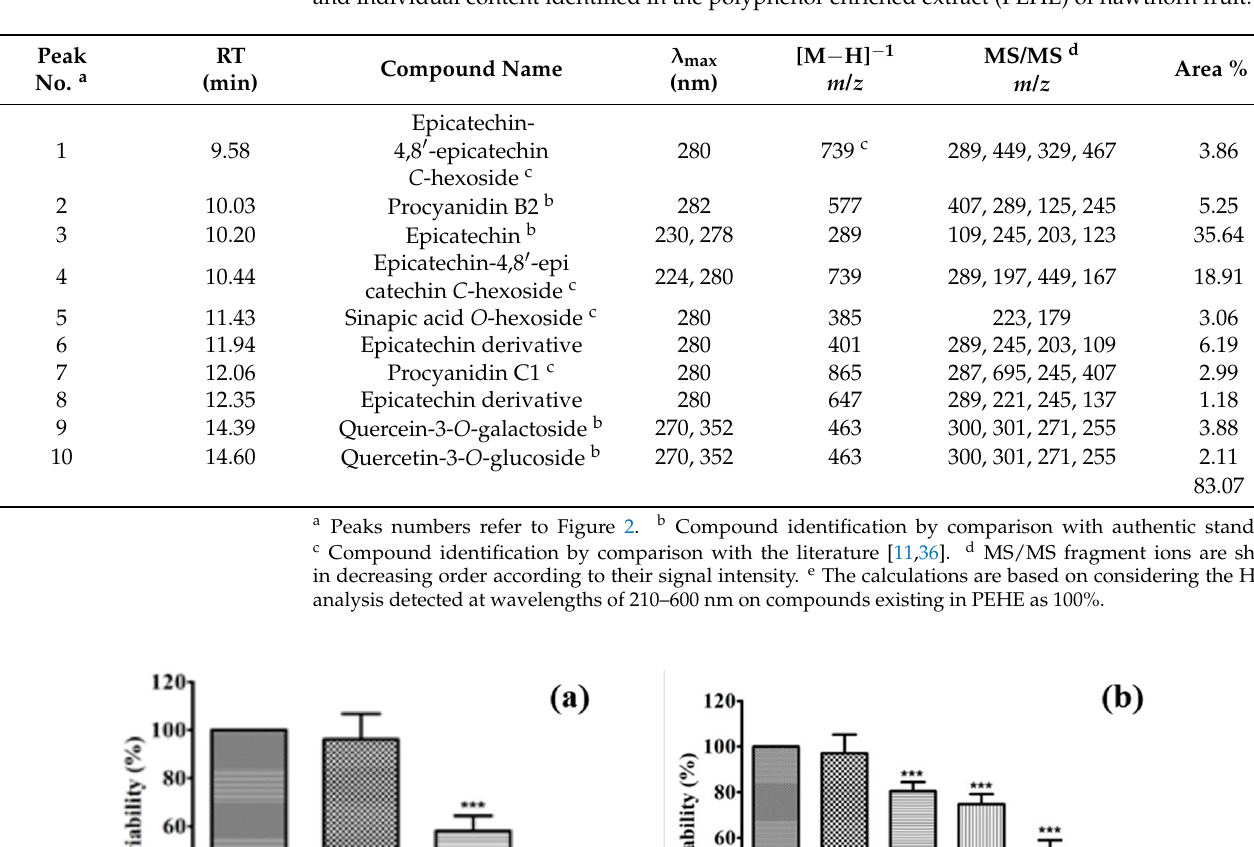
Table 3. HPLC–DAD–ESI–MS/MS analysis on the chromatographic and spectroscopic characteristics and individual content identified in the polyphenol-enriched extract (PEHE) of hawthorn fruit.